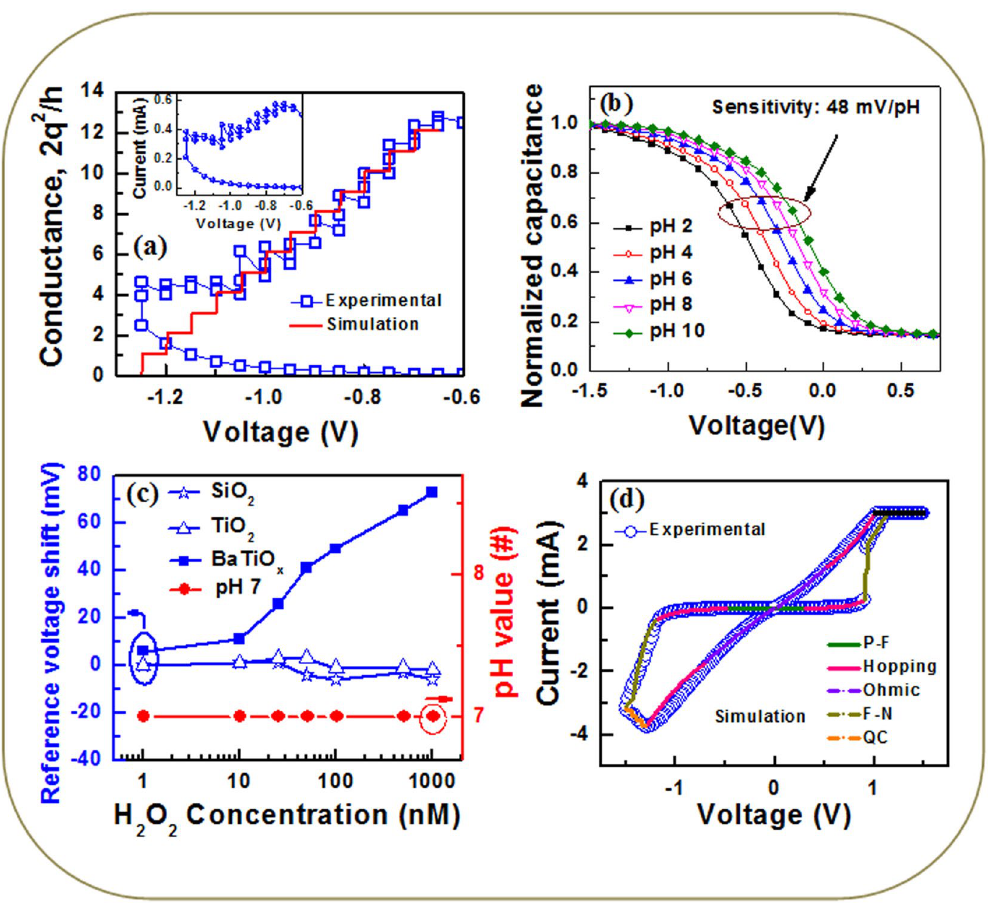
Figure 10. ( a ) Experimental and simulated conductance curve as a function of voltage. Inset shows the I–V of the RESET region. ( b ) C–V characteristics with pH values of 2 to 10. ( c ) Reference voltage shift with H 2 O 2 concentration from 1 nM to 1000 nM. ( d ) Experimental and simulated I-V